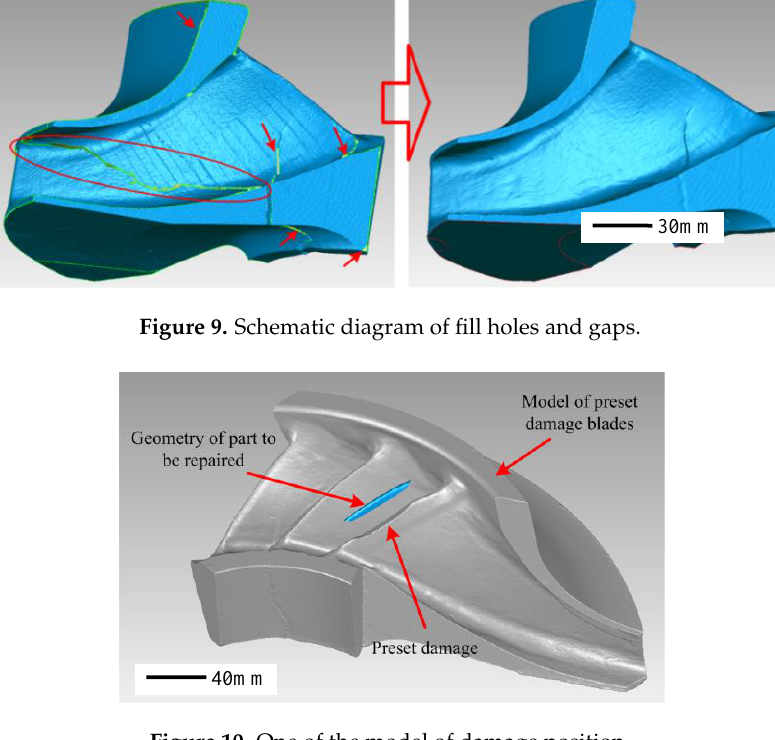
Figure 10. One of the model of damage position.